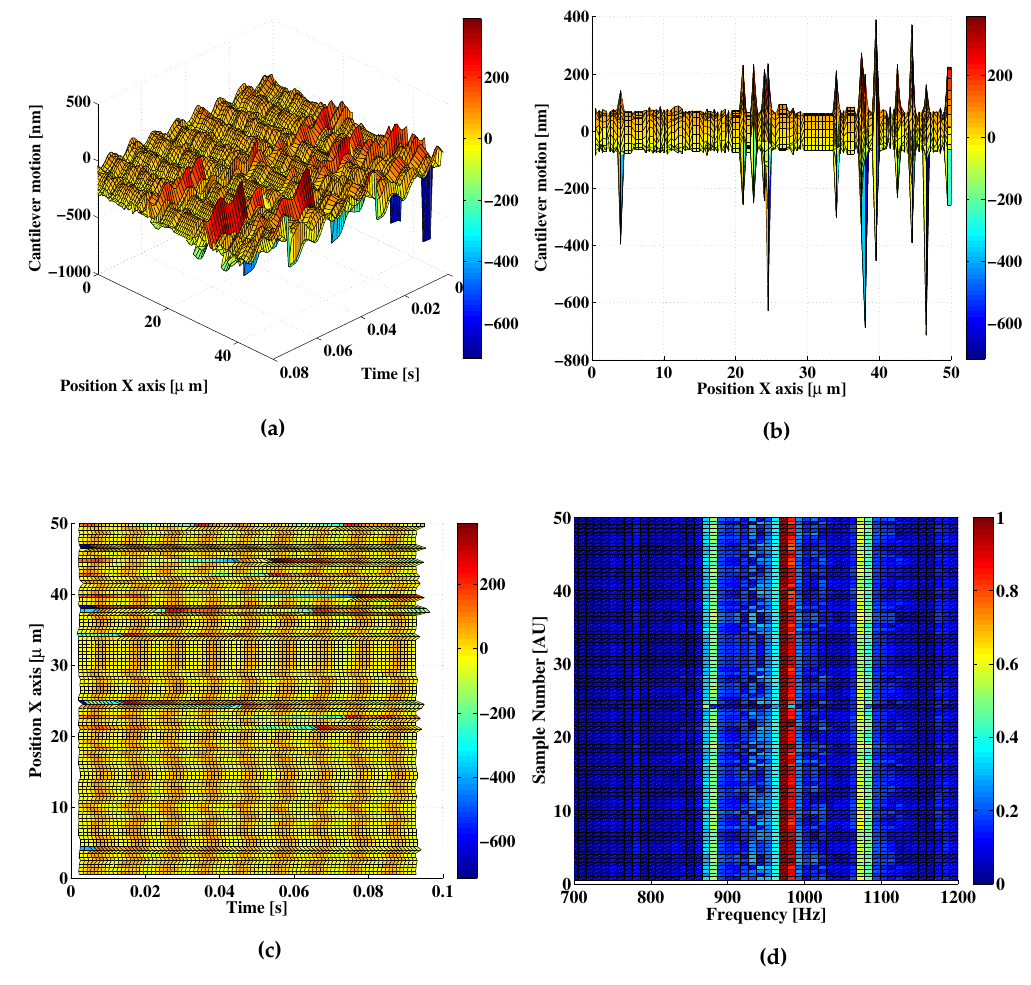
Figure 11. Example of an experimental A = 100-nm cantilever displacement reconstruction under uncontrolled acoustic and mechanical noise conditions. The displacement is shown in different projections: ( a ) 3D; ( b ) top and ( c ) lateral view; ( d ) The top view of the Fourier spectra around the main harmonic of the OFI measurement signal for each of the points acquired in the